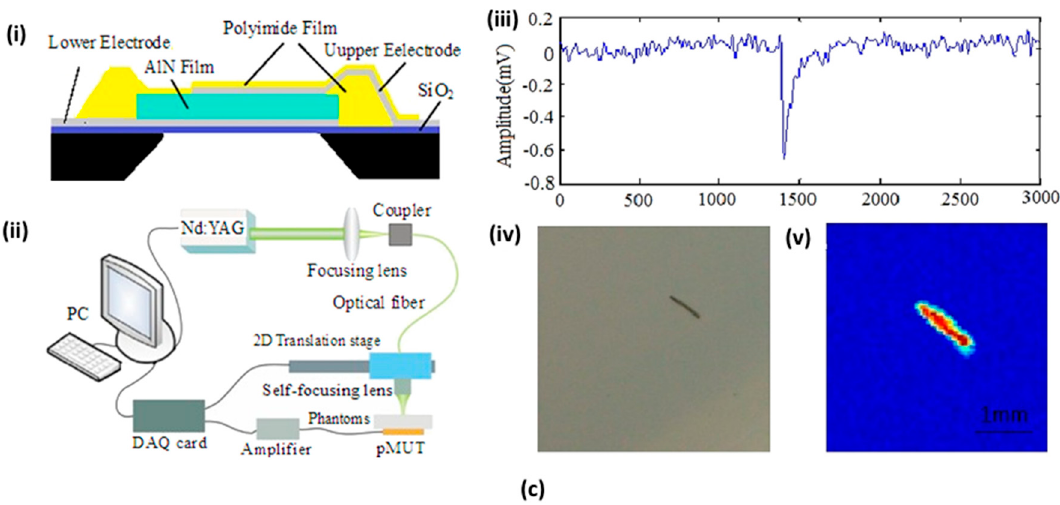
Figure 5. ( a ) A ring-type capacitive micromachined US transducers (CMUT) array for PAI. ( ai ) Schematic and an optical microscopic view of the 512-element four-ring CMUT array. ( aii ) A ring CMUT array installed into handmade electronics. ( aiii ) Volumetric US image of a metal spring with the ring CMUT array [88]. Reproduced with permission from Nikoozadeh, Amin, et al., an integrated Ring CMUT array for endoscopic ultrasound and photoacoustic imaging; published by IEEE, 2013. ( b ) Multi-band CMUT array for PAI ( bi ) The photograph of multi-band CMUT array. ( bii ) Magnified optical microscopic view of multi-band CMUT array. ( biii , biv ) In vivo PA images of a zebrafish measured by the low- and high-frequency CMUT arrays, respectively [90]. Reproduced with permission from Zhang, Jian, et al., development of a multi-band photoacoustic tomography imaging system based on a capacitive micromachined ultrasonic transducer array; published by OSA, 2017. ( c ) A PMUT based on AlN and acquired PA image ( ci ) Structure of PMUT based on AlN. ( cii ) Experimental setup of photoacoustic imaging with PMUT. ( ciii ) Acquired PA signal of the hair ( civ ) of human hair embedded in the phantom. ( cv ) Reconstructed PA image [98]. Reproduced Photography of human hair embedded in the phantom. ( cv ) Reconstructed PA image [98].